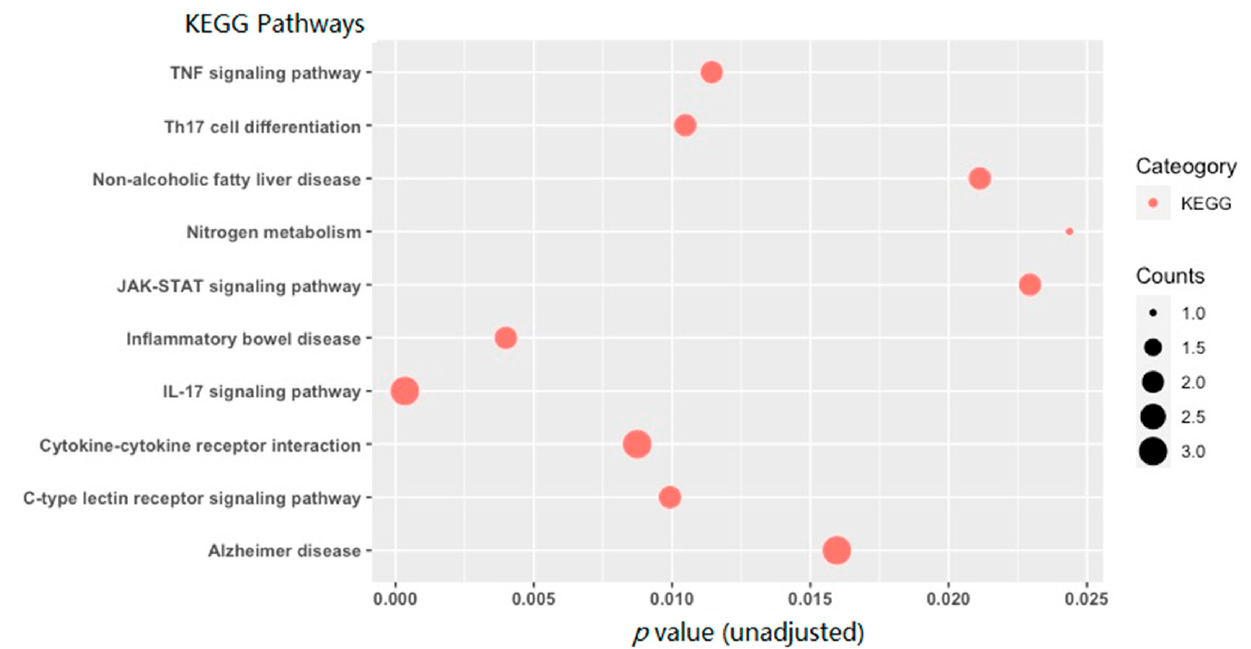
Figure 5. A bubble plot of the top 10 KEGG pathways (unadjusted p ≤ 0.03 and adjusted p ≤ 0.200) obtained by enrichment analysis of differentially methylated mRNAs (|FC| ≥ 2 and p -value < 0.05). The size of the bubble for each enrichment term corresponds to the number of enriched genes within that KEGG term.